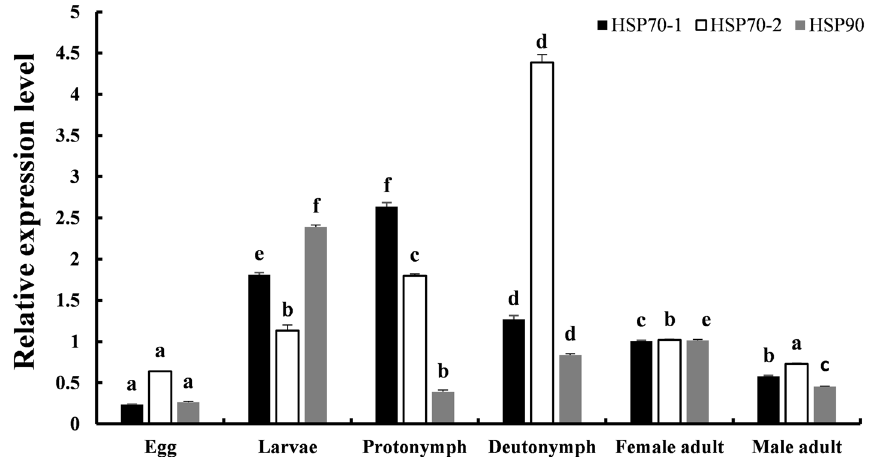
Figure 4. Stage-specific TpHSP70-1 , TpHSP70-2 and TpHSP90 expression in T.putrescentiae . The mRNA expression level of TpHSP70-1 , TpHSP70-2 and TpHSP90 genes in different developmental stages including egg, protonymph, deutonymph, tritonymph and adult stages of T.putrescentiae was measured by fluorescent real- time quantitative PCR. Values are the mean ± SD (n = 200). The different letters above the bars ( a – f ) indicate a significant difference in the means as assessed using Duncan’s multiple comparison tests ( P <